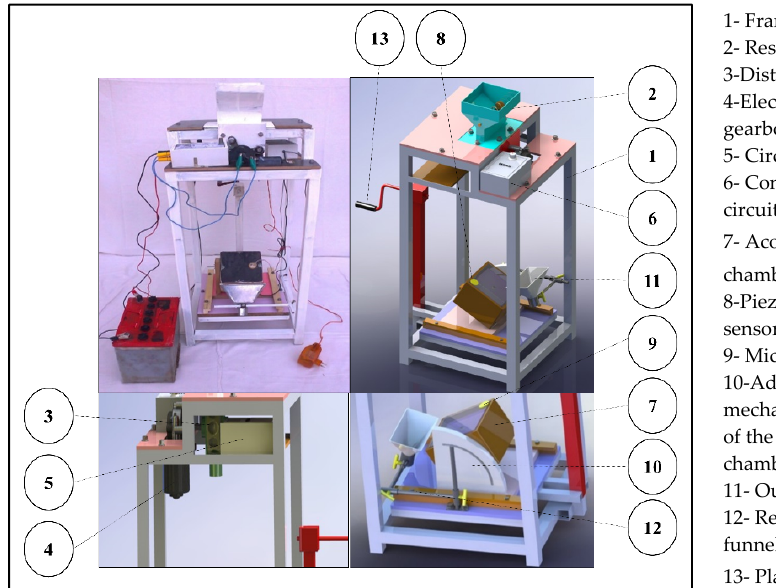
Figure 2. The designed system and its components.